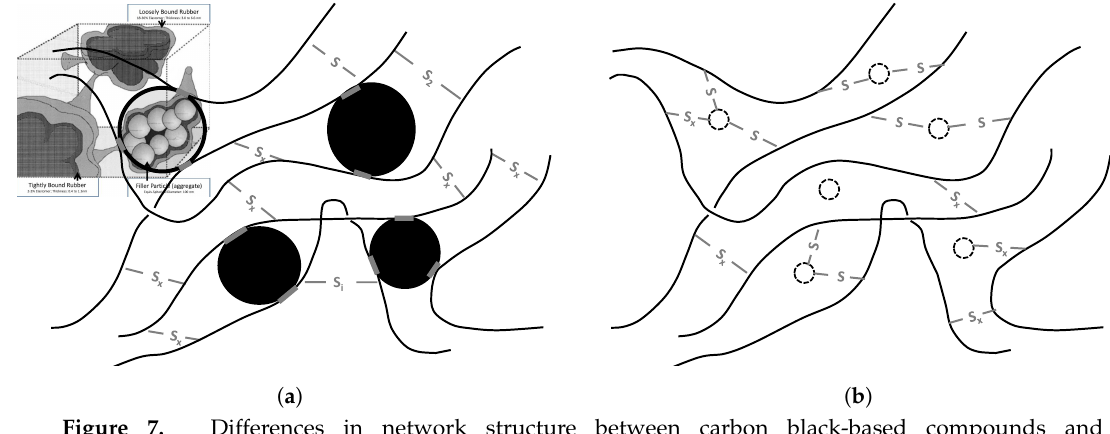
Figure 7. Differences in network structure between carbon black-based compounds and silica-silane-based compounds. ( a ) Sulfide bonds in carbon black rubber. Insert bound rubber by Leblanc [15]. ( b ) Sulfide bonds in silica-silane-based rubber. High amount of (mono)sulphidic bonds between silica and